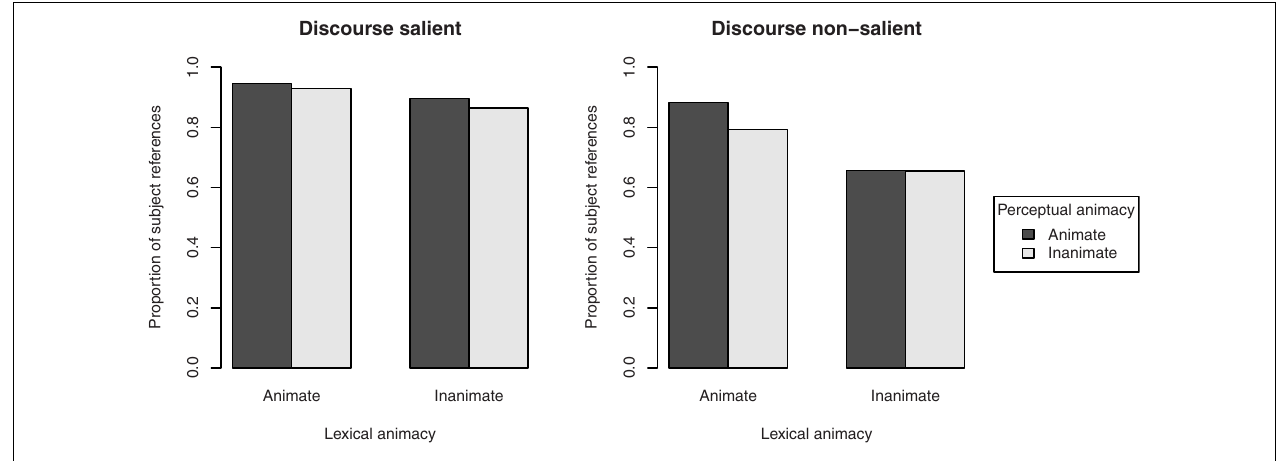
FIGURE 3 | Proportion of subject references to the target figure in the description of the transitive action in Experiment 1, by its lexical and perceptual animacy, and split by the discourse salience of the referent: